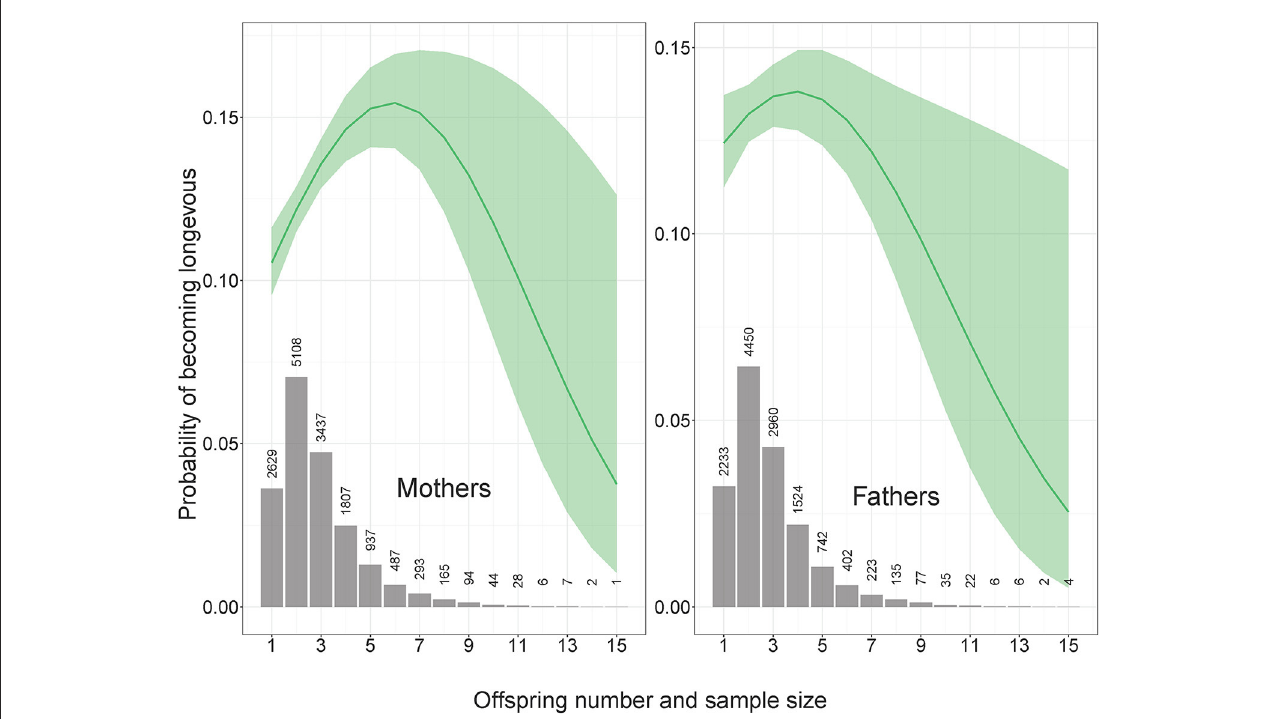
FIGURE1 Probability of becoming longevous as a function of offspring number. Mothers: OR (95% CI) for offspring number and offspring number squared 1.24 (1.12–1.37) and 0.98 (0.97–0.99), n longevous = 1,477, n non-longevous = 9,990. Fathers: OR (95% CI) for offspring number and offspring number